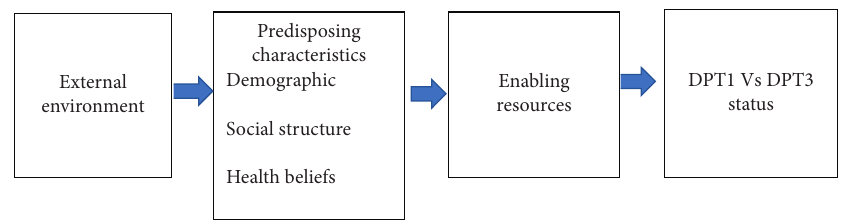
Figure 1: A theoretical framework based on health belief model for the present study. Table 2: Cross tabulation between external environment and DPT1 Vs DPT3